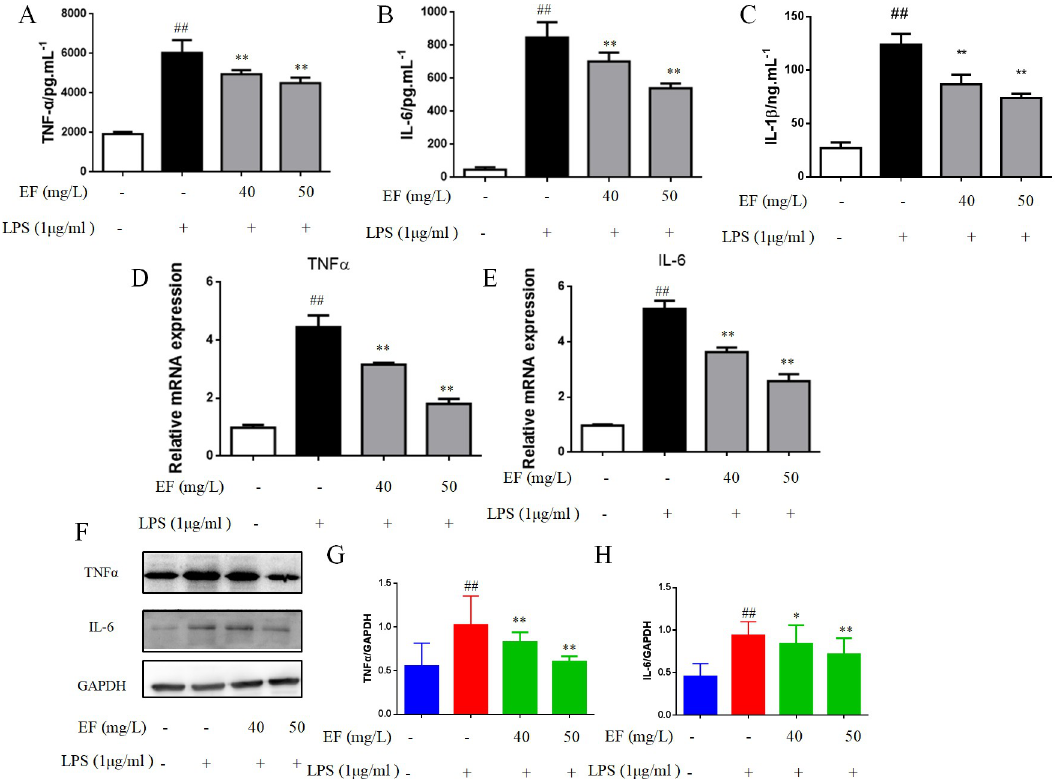
Fig 3. EF decreased LPS-stimulated expression of pro-inflammatory cytokines in RAW 264.7 macrophages cells. A/B/C: the supernatant levels of TNF- α , IL-6 and IL-1 β were identified by ELISA. D/E: The mRNA levels of TNF- α and IL-6 were determined by quantitative real-time PCR. F/G/H: The protein level of TNF- α and IL-6 was determined by Western blotting analysis using specific antibodies. All data are shown as mean ± SEM (n = 6, per group) ##P < 0.01 vs control; � P < 0.05, �� P < 0.01 vs